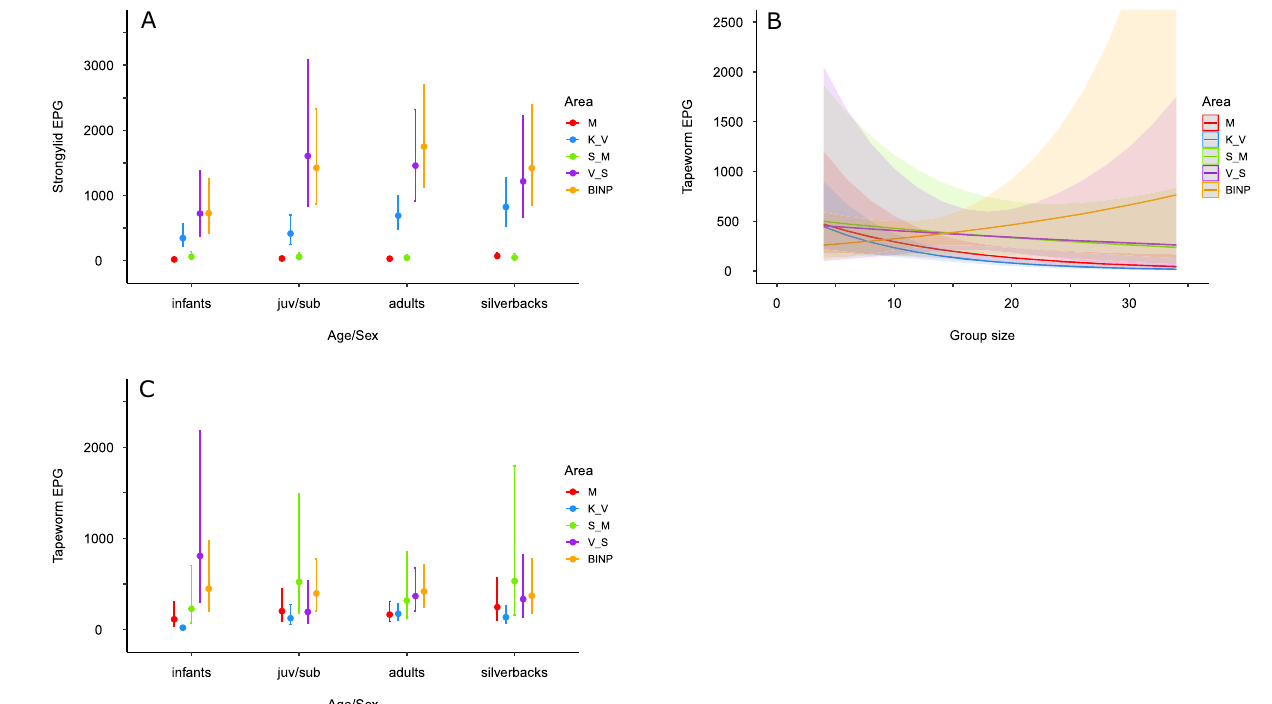
Figure 3. Models’ predicted mean values with 95% confidence intervals for the factors affecting helminth infections in mountain gorillas in Virunga Massif and Bwindi Impenetrable National Park (dataset 1). ( A ) strongylid eggs per gram (EPG)—sampling area and age/sex class effects, ( B ) tapeworm EPG—sampling area and group size effects, ( C ) tapeworm EPG—sampling area and age/sex class effects. juv/sub: juvenile/subadult